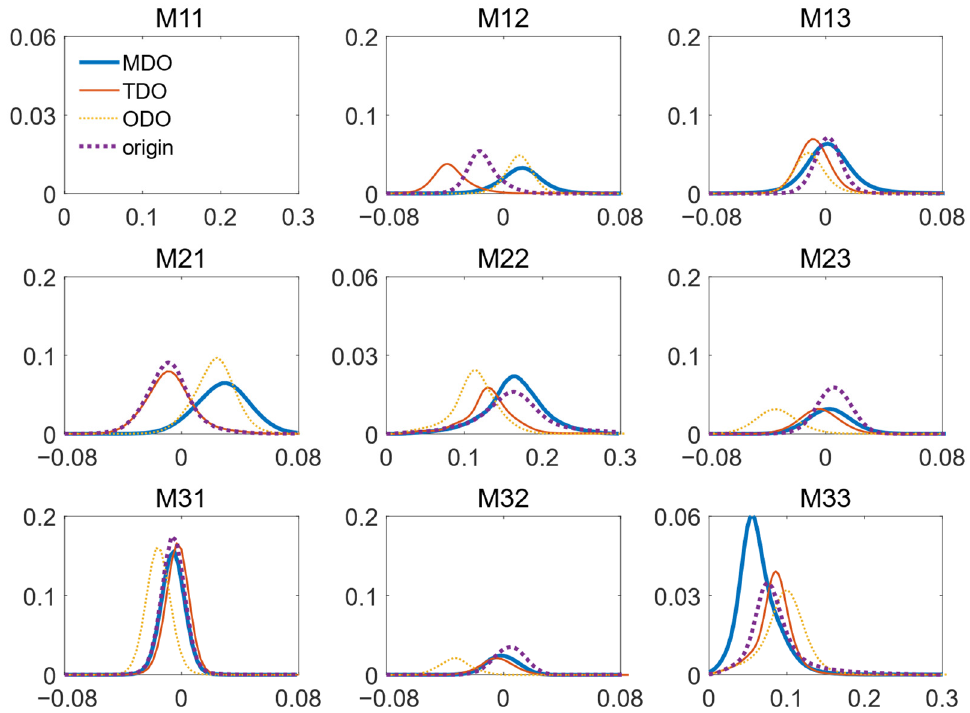
Figure 4. Frequency distribution histograms (FDHs) of 3 × 3 Mueller matrix elements for bovine tendon tissues in four states: origin, TDO, MDO and ODO. The horizontal axis is divided into 400 intervals, and the vertical axis coordinates represent the probability that the data points will fall into one of the intervals of the horizontal axis. Here, the coordinate ranges are determined according to Ref. [24].